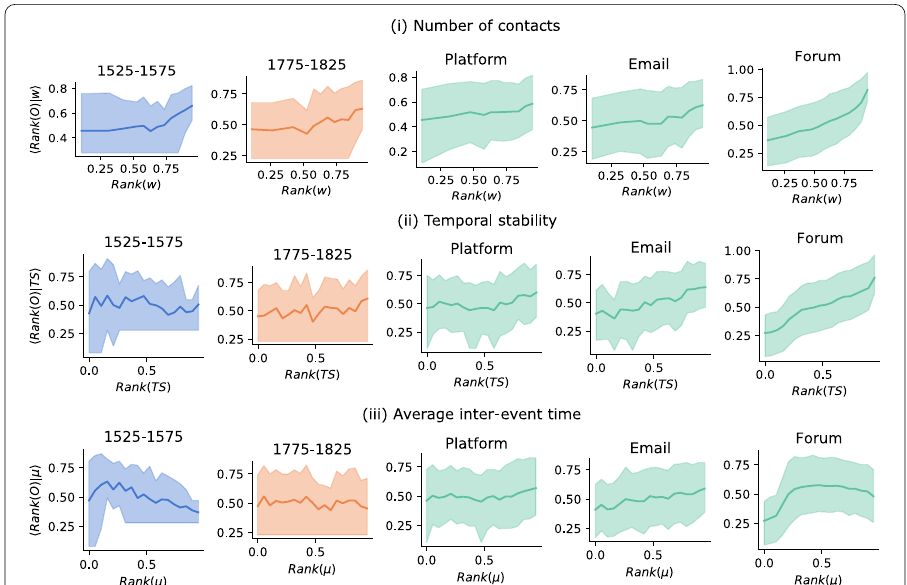
Fig. 5 Granovetter effect for different features of communication on ( left to right ) two snapshots of Letters (1525–1575) and reference datasets Platform, Email and Forum (the effect has already been described in Mobile by Ureña‑Carrion et al. 2020). The embeddedness of ties, as measured by topological overlap, changes in association with behavioural communication features, although not always in a linear fashion. Shaded area represents 80% of the distribution. Features of communication: ( i ) number of contacts w , ( ii ) temporal stability TS and ( iii ) Mean IET µ . The Granovetter effect is most visible for w . Using TS as a proxy for tie strength we do not observe the effect for Letters and we only observe it partly for Platform. For µ , the effect (decrease of overlap with larger average IET) is visible for the period 1525–1575 and partially for larger values of